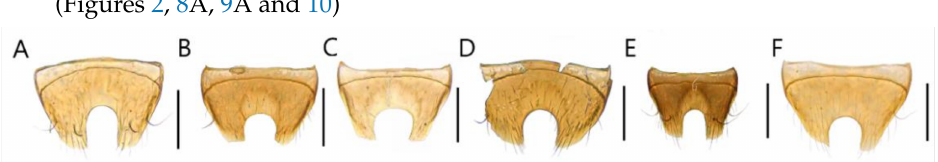
Figure 7. Adult of Edaphus koreanus Puthz: ( A ) dorsal view; ( B ) head; ( C ) pronotum; ( D ) elytra; ( E ) meso and metasternum; ( F ) abdominal tergites; ( G ) abdominal sternites; ( H ) fore leg; ( I ) middle leg; ( J ) hind leg; ( K ) antenna; ( L ) maxillary palp; ( M ) labrum; ( N ) mandibles. Scale bars: ( A ) = 1 mm; ( B – J ) = 0.3 mm; ( K – N ) = 0.1 mm. Distribution. Palaearctic, Oriental, Afrotropical, Australian, Nearctic, Neotropical, Pacific Edaphus haenamensis Byeon, Park, Lee, and Park sp.n. (Figures 2, 8A, 9A and 10)